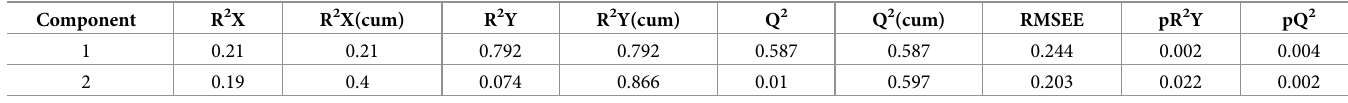
Table 2. Standard scaling of predictors and response.